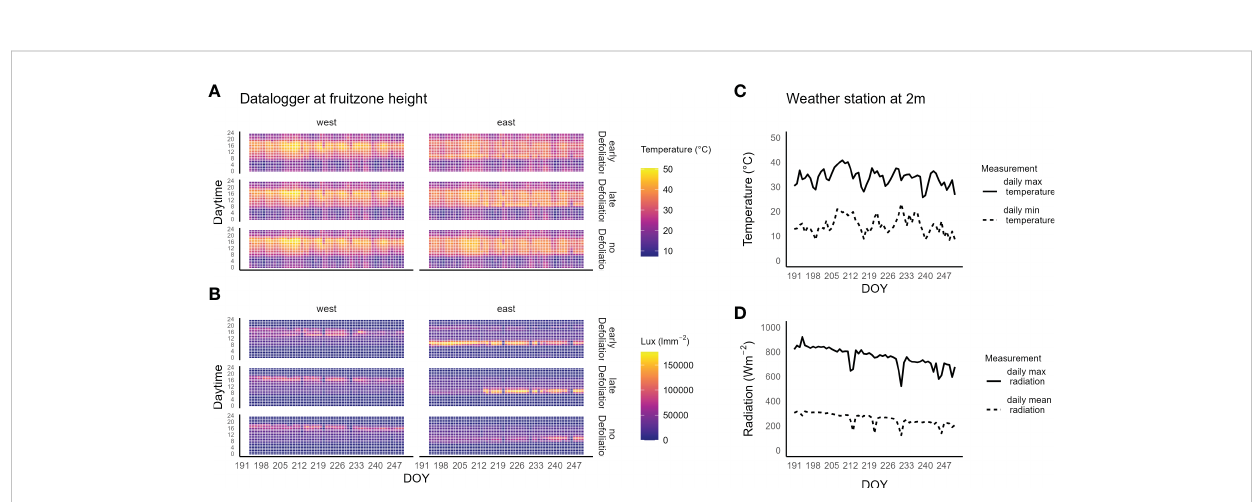
FIGURE 2 (A) Heatmap of the hourly mean temperature of Riesling grapes in a vineyard in southeastern Washington, USA. (B) Heatmap of the hourly mean light intensity. Measurements were taken on drought stressed vines at fruit-zone height on the east and west side of the canopy for three